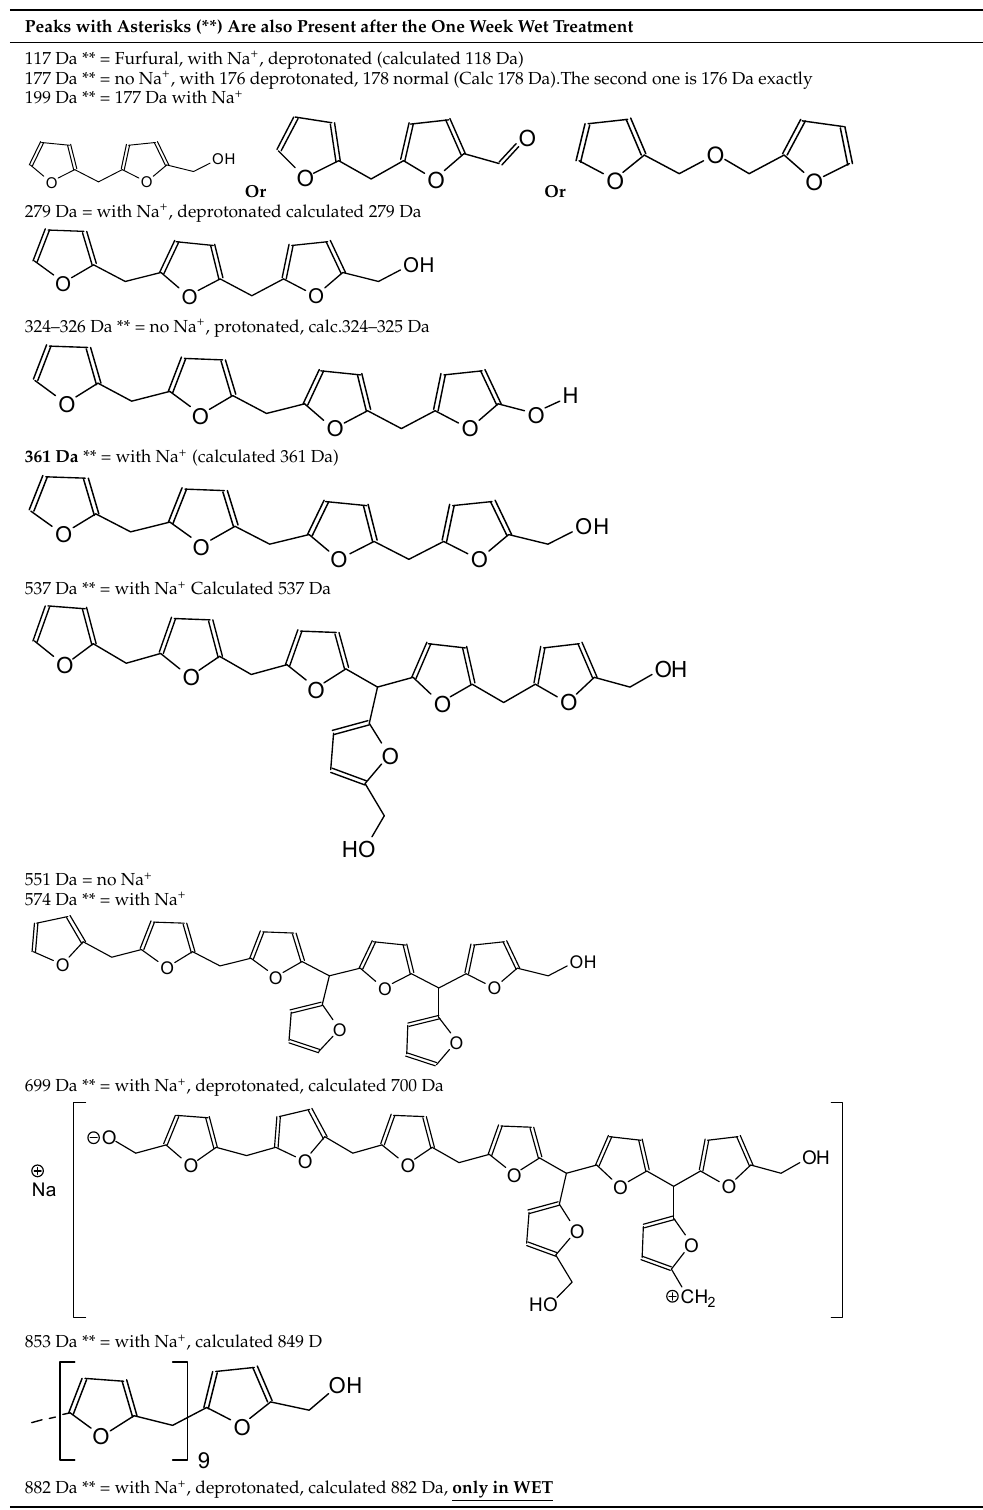
279 Da = with Na + , deprotonated calculated 279